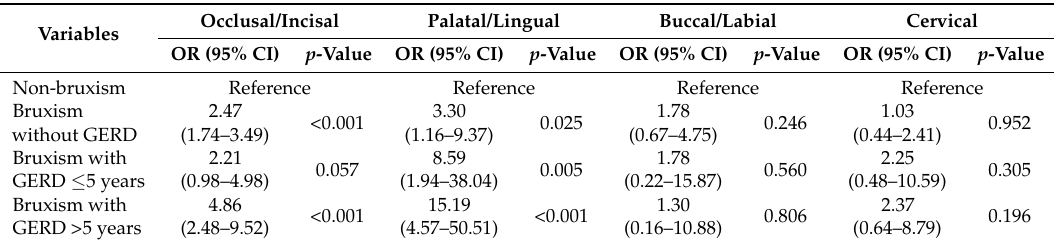
Table 4. Associations among bruxism, GERD, and severe tooth wear for different tooth surfaces in the univariate analysis.